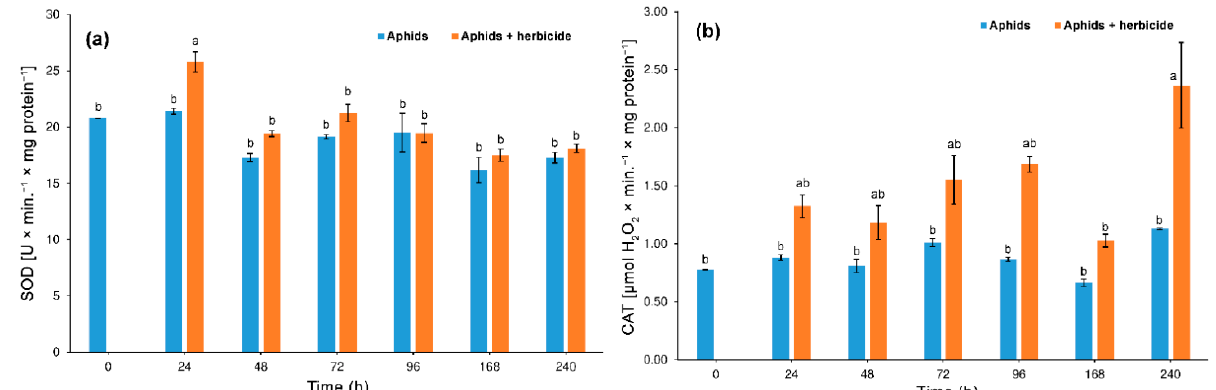
Figure 5. Activity change of superoxide dismutase (SOD) ( a ) and catalase (CAT) ( b ) in the tissues of hemp aphid ( Phorodon cannabis ) hemp plants ( Cannabis sativa ) following the application of Pantera 040 EC graminicide (mean ± SE; control = aphids on untreated C. sativa ). Values not followed by the same letter are significantly different at the level of p < 0.05 (Tukey multiple range test).